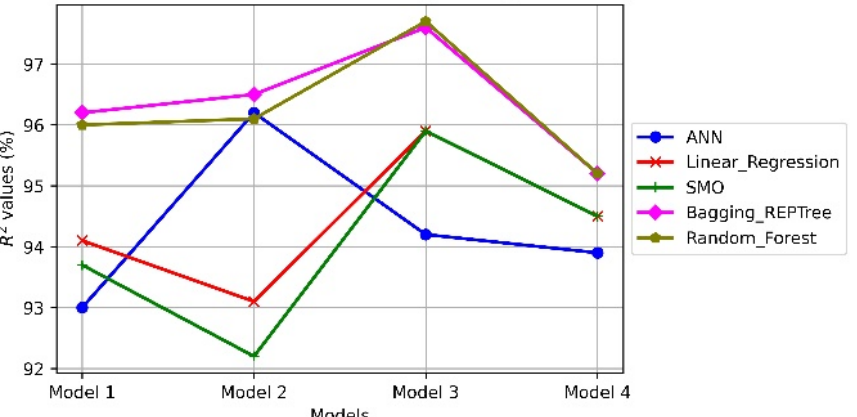
Figure 3. The R 2 results of using ML techniques on YouTube dataset.